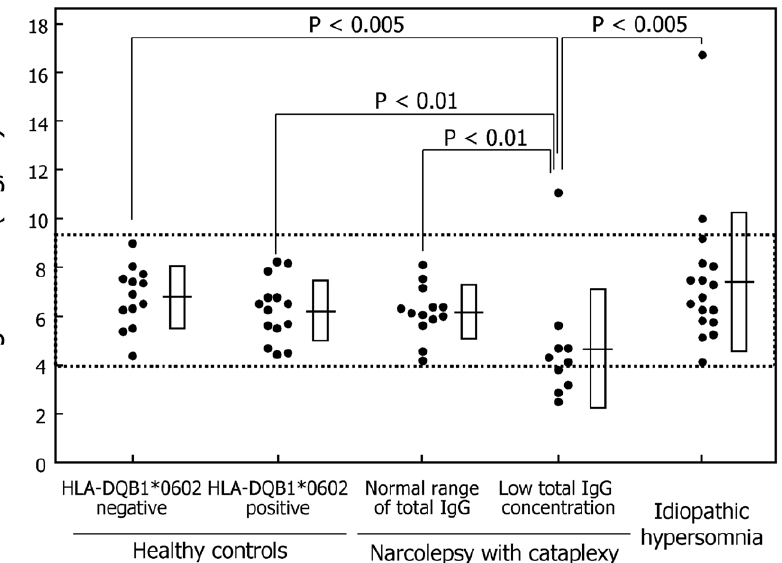
Figure 2. Serum IgG1 level. Each dot corresponds to the serum IgG subclass level (mg/ml) in each subject. Dotted lines indicate the mean 6 2SD of healthy control subjects without DQB1*0602 as normal range. Horizontal lines and squares indicate the mean 6 SD of five groups.